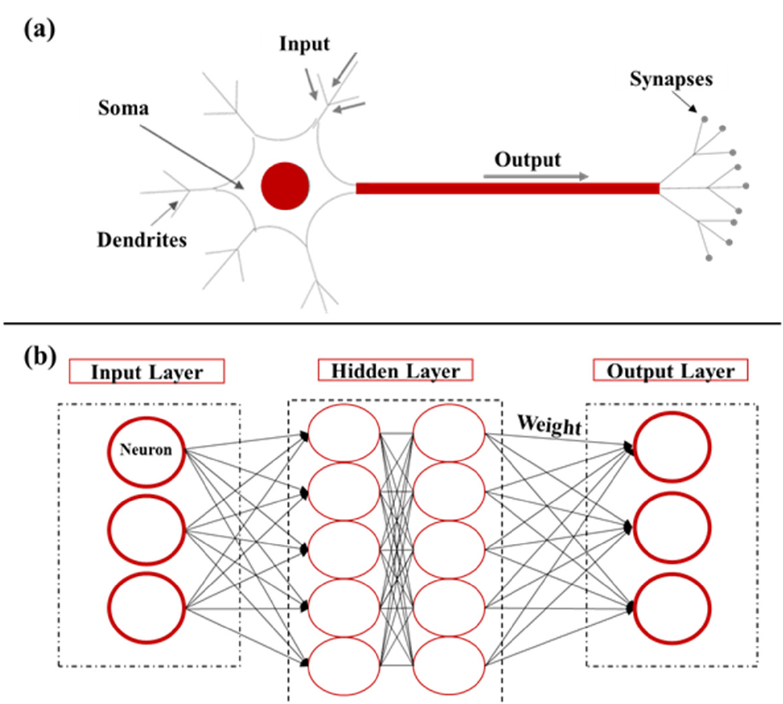
Figure 2. ( a ) Biological neuron architecture. ( b ) Artificial neural network architecture. ( a ) The labeled main parts of the neuron form the passage of the message from the input dendrites to the output synapses. ( b ) We labeled the main parts of an artificial neuron network for the usual three layers (input layer, hidden layer, and output layer).